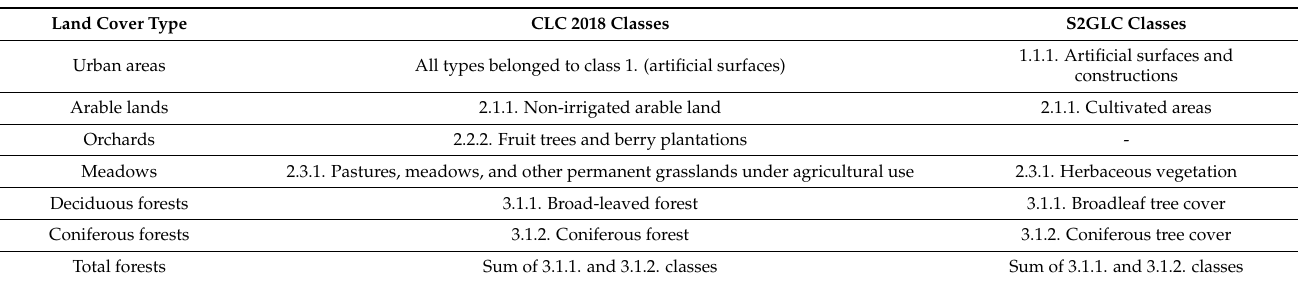
Table 1. CLC 2018 and S2GLC classes used for land cover metric